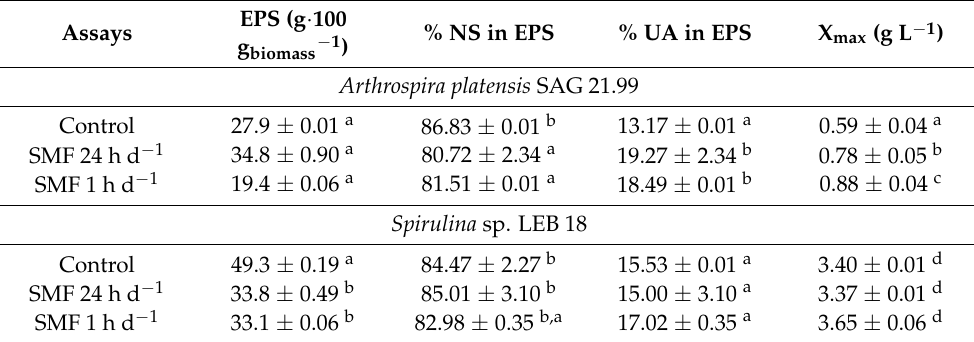
Table 2. Exopolysaccharides (EPS) production yield and global osidic